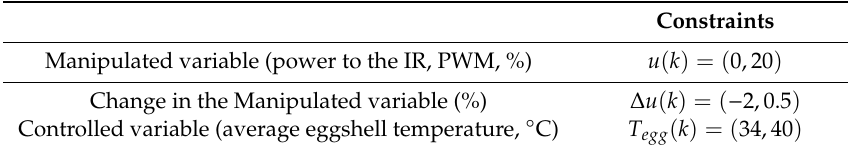
Table 2. The predefined constraints on both the controlled and manipulated variables, which should be considered for designing the MPC